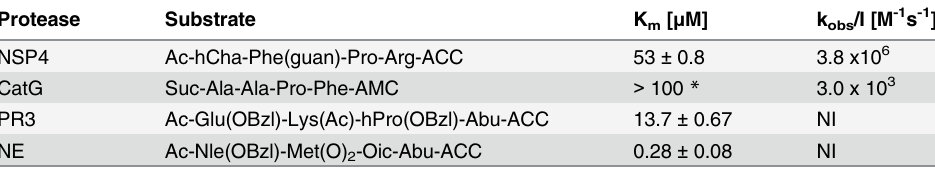
Table 3. Inhibition rate constants of NSPs by Biot-Ahx-hCha-Phe(guan)-Oic-Arg P (OPh) 2